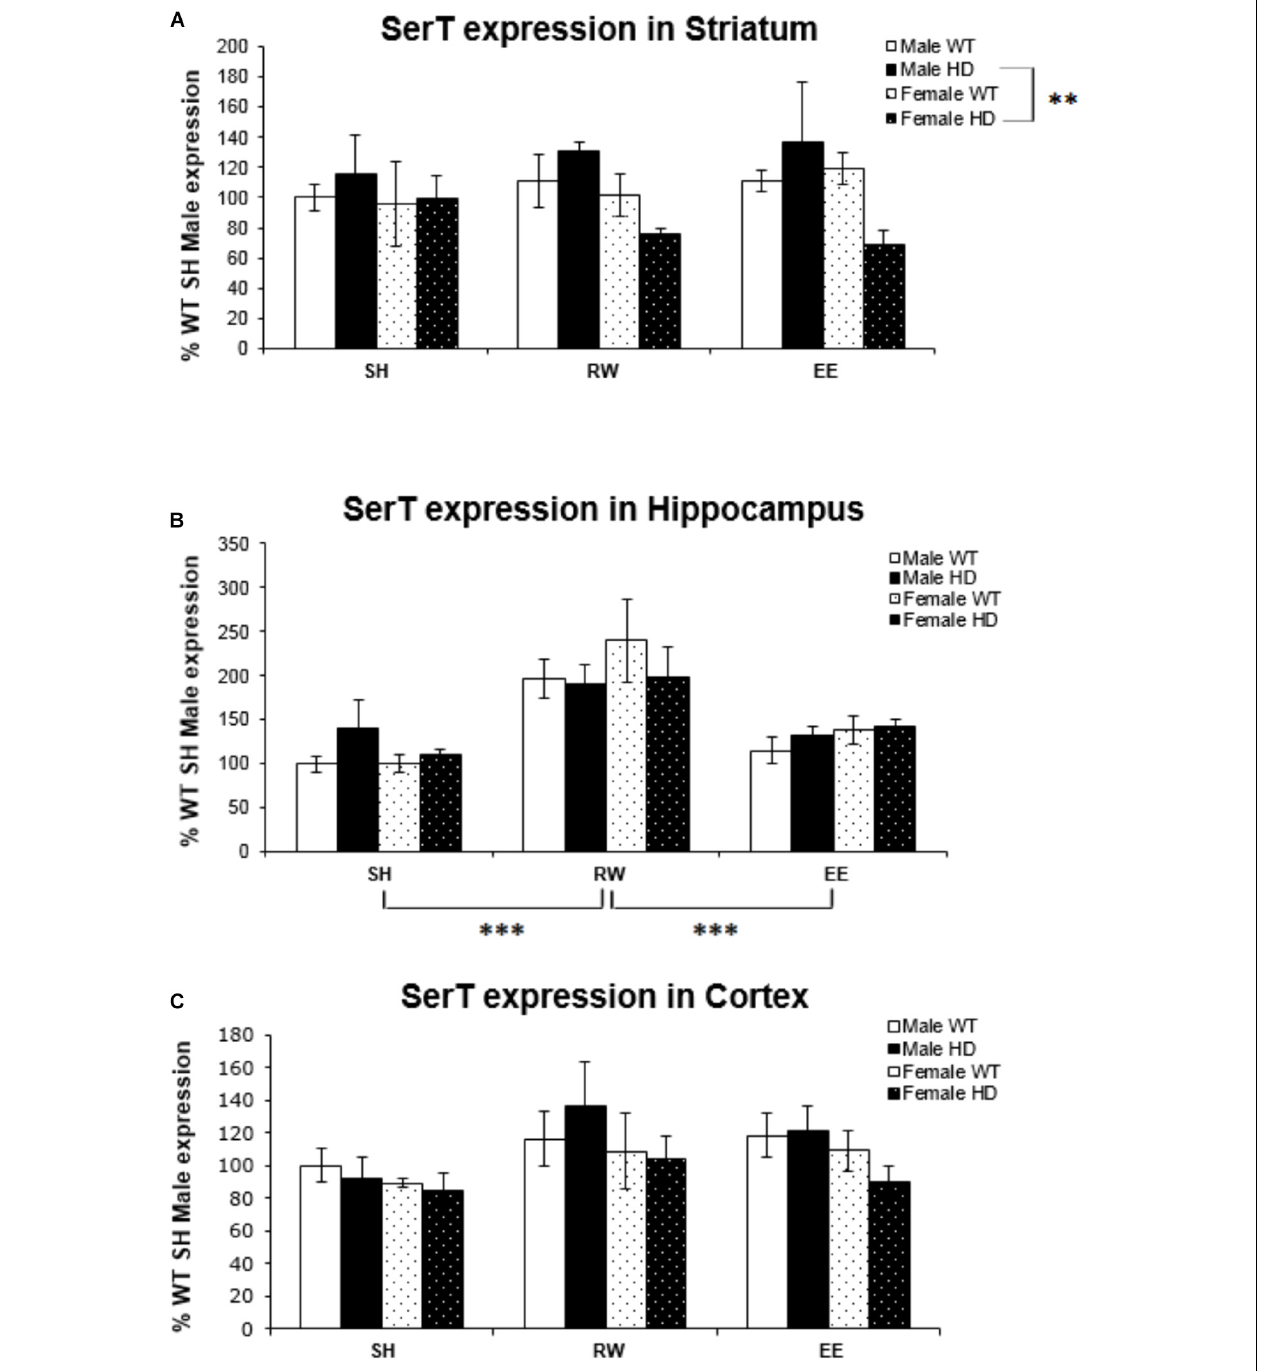
FIGURE 1 | Effects of environmental interventions and sex on SerT mRNA levels in 8-week-old WT and HD mice. (A) In Striatum, SerT expression was unaffected by genotype ( p = 0.862) and housing environment ( p = 0.867). Sex did significantly affect SerT mRNA levels ( p = 0.019). There was a significant interaction between genotype × sex ( p = 0.030); pairwise comparisons showed a significantly less SerT mRNA in female HD mice when compared to male HD mice ( p = 0.002). (B) In Hippocampus, SerT expression was unaffected by genotype ( p = 0.774) or sex ( p = 0.506). Housing environment significantly affected SerT expression levels ( p < 0.001). Post hoc testing showed that wheel running ( p < 0.001), but not environmental enrichment ( p = 0.510), significantly increased levels of SerT mRNA. (C) In Cortex, SerT expression was unaffected by genotype ( p = 0.816). There were no effects of sex ( p = 0.065) or housing environment ( p = 0.063). n = 4–6 per group. Results are represented as mean ± SEM. Pairwise comparisons were conducted using Bonferonni’s adjustment for multiple comparisons: ∗∗ p ≤ 0.01; ∗∗∗ p ≤ 0.001.